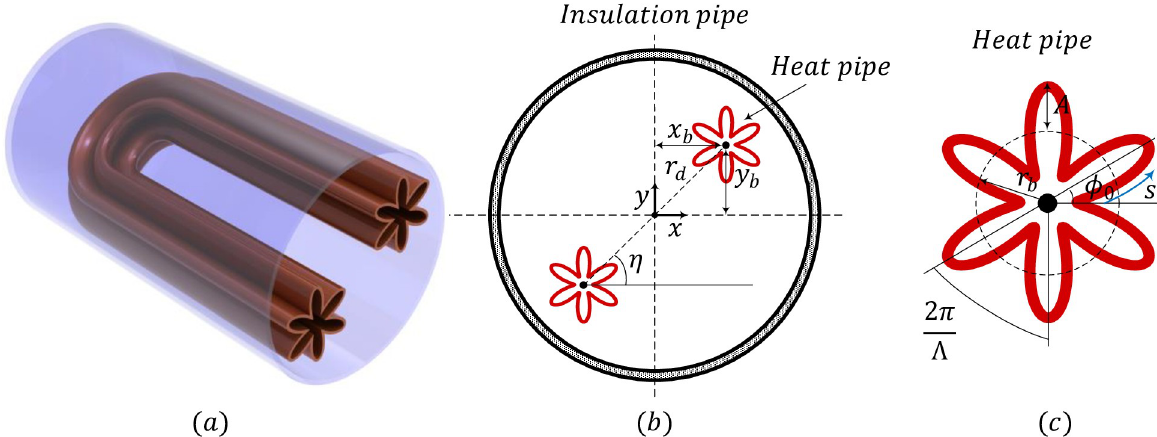
Fig 1. The configuration of the problem